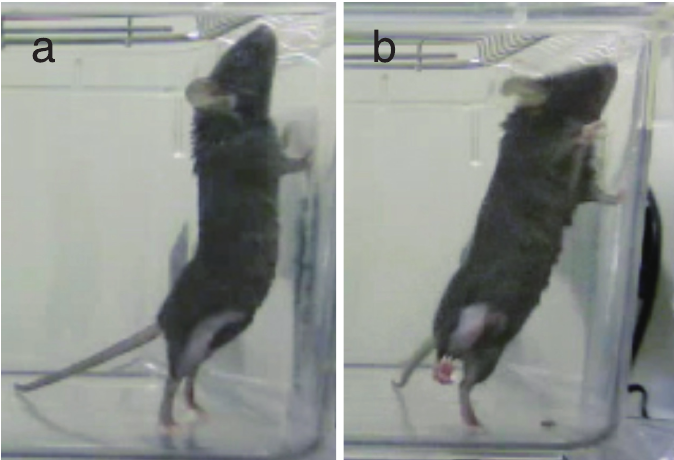
Fig 2. Observation of pain-related behavior of mice. When control mice were allowed to move freely in the cage, they occasionally rear up with their front limbs on the wall of cage (a). When MIA was injected to the right knee joints, mice sometimes stood with their left hind limb alone that was not treated with MIA